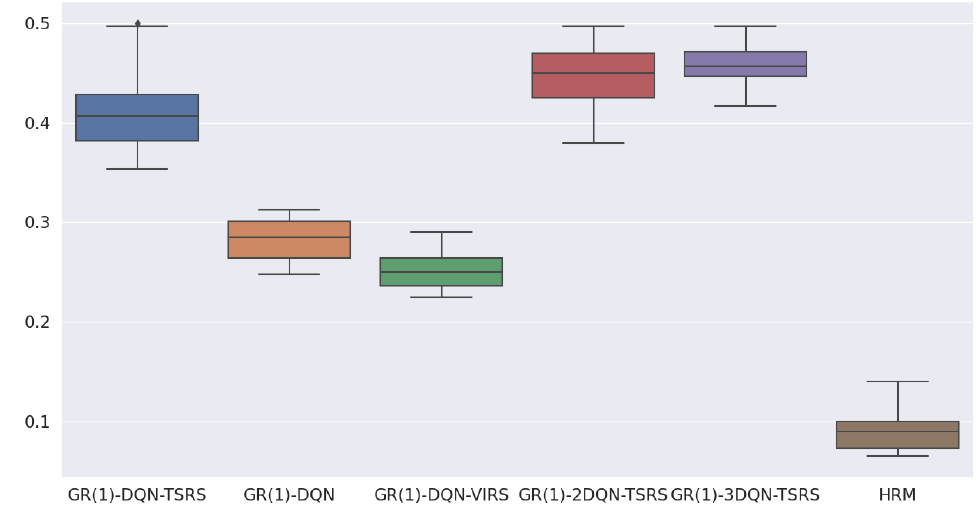
Figure 14. Box plot of learning curve for ϕ 2 under the environment setting 1.